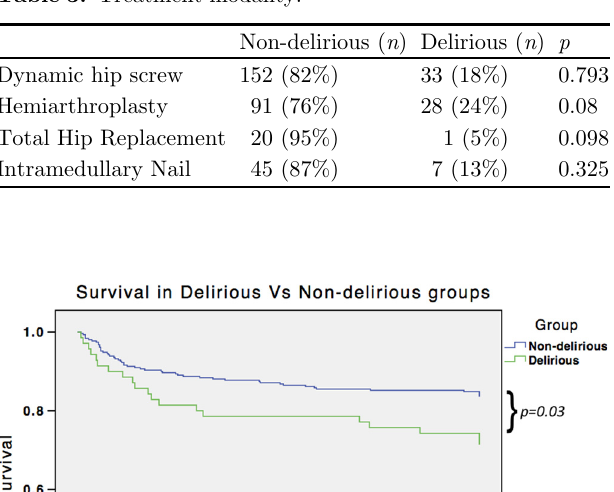
Table 3. Treatment modality. Table 4. Mortality.